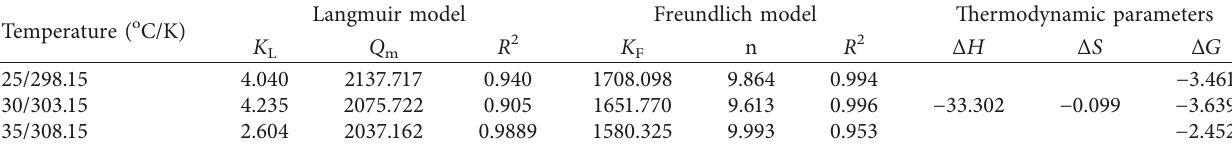
Table 5: Langmuir model, Freundlich model, and thermodynamic parameters of the antioxidants in MD on HPD500 resin. Temperature ( o C/K)